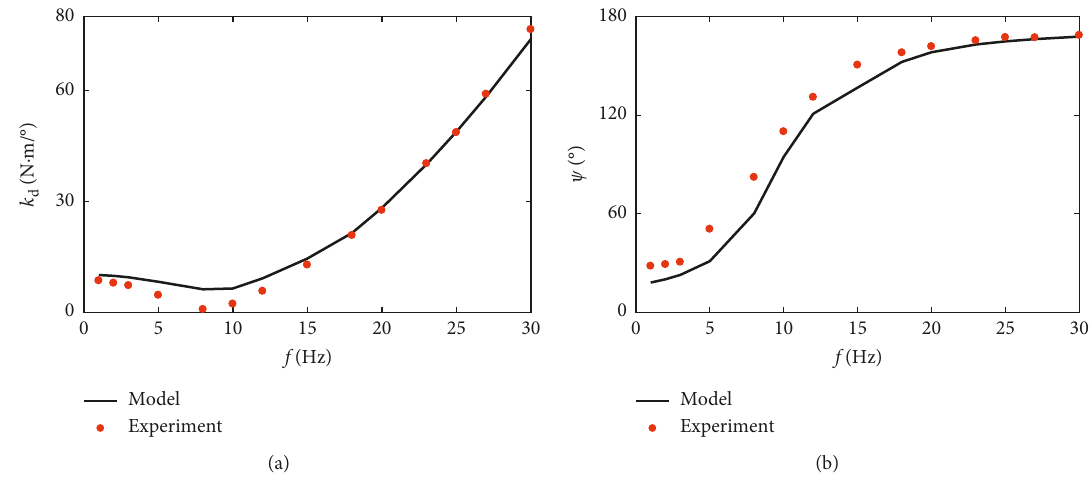
Figure 13: Excitation amplitude θ